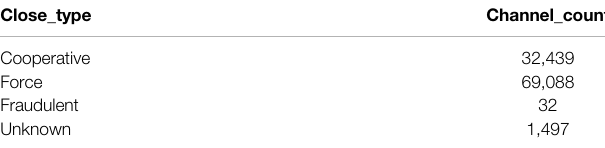
TABLE 4 | The number of channels with different closing methods.